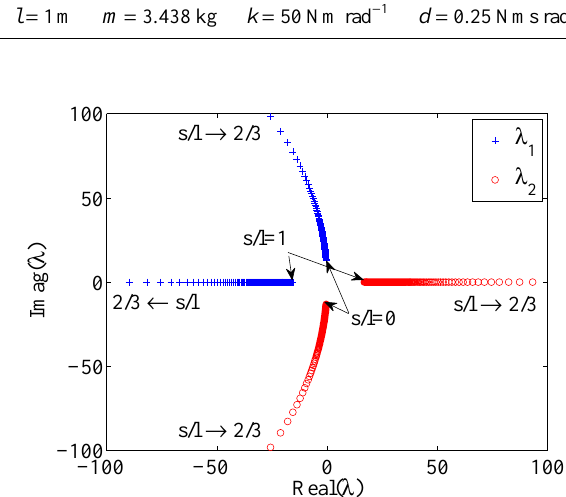
Table 2. Properties for rotational manipulator arm.